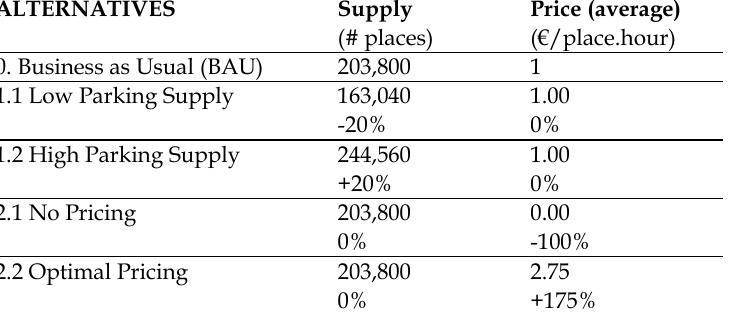
Table 1. Policy alternatives